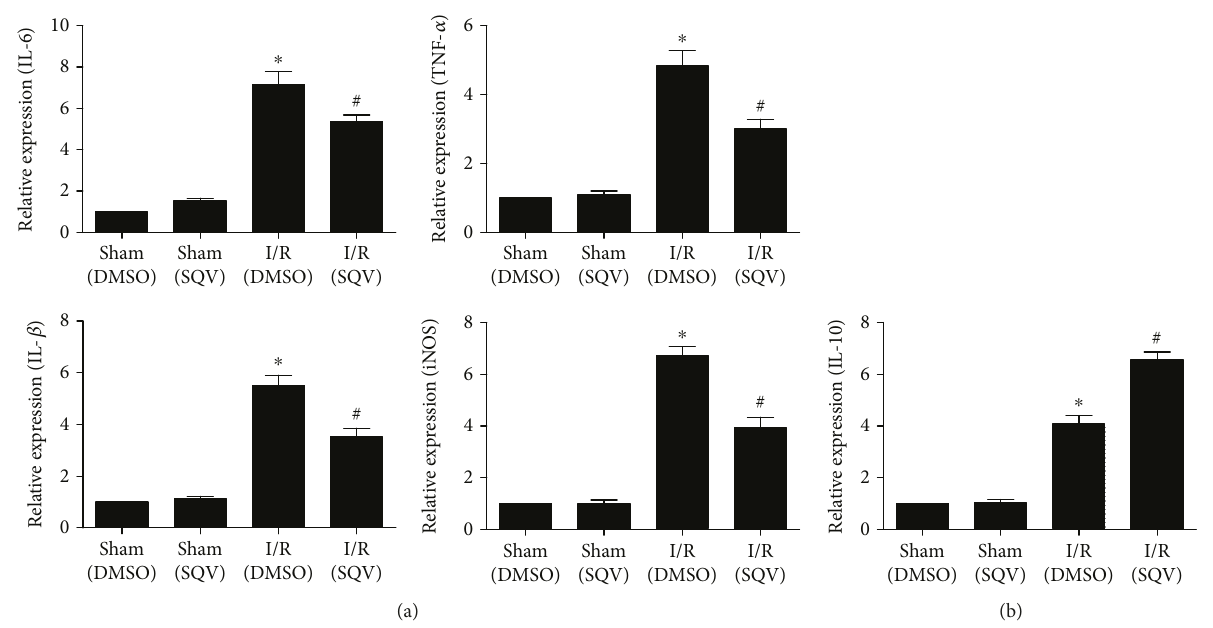
Figure 4: SQV suppresses the level of proin fl ammatory cytokines and upregulates the level of anti-in fl ammatory cytokines in the serum and BALF following liver warm I/R. ELISA was performed to check the concentration of cytokines, such as IL-6, TNF- α , and IL-10 in BALF (a) and serum (b). GraphPad values are presented as mean ± SEM. ∗ P < 0 05 versus the Sham group; # P < 0 05 compared to the liver warm I/R group.